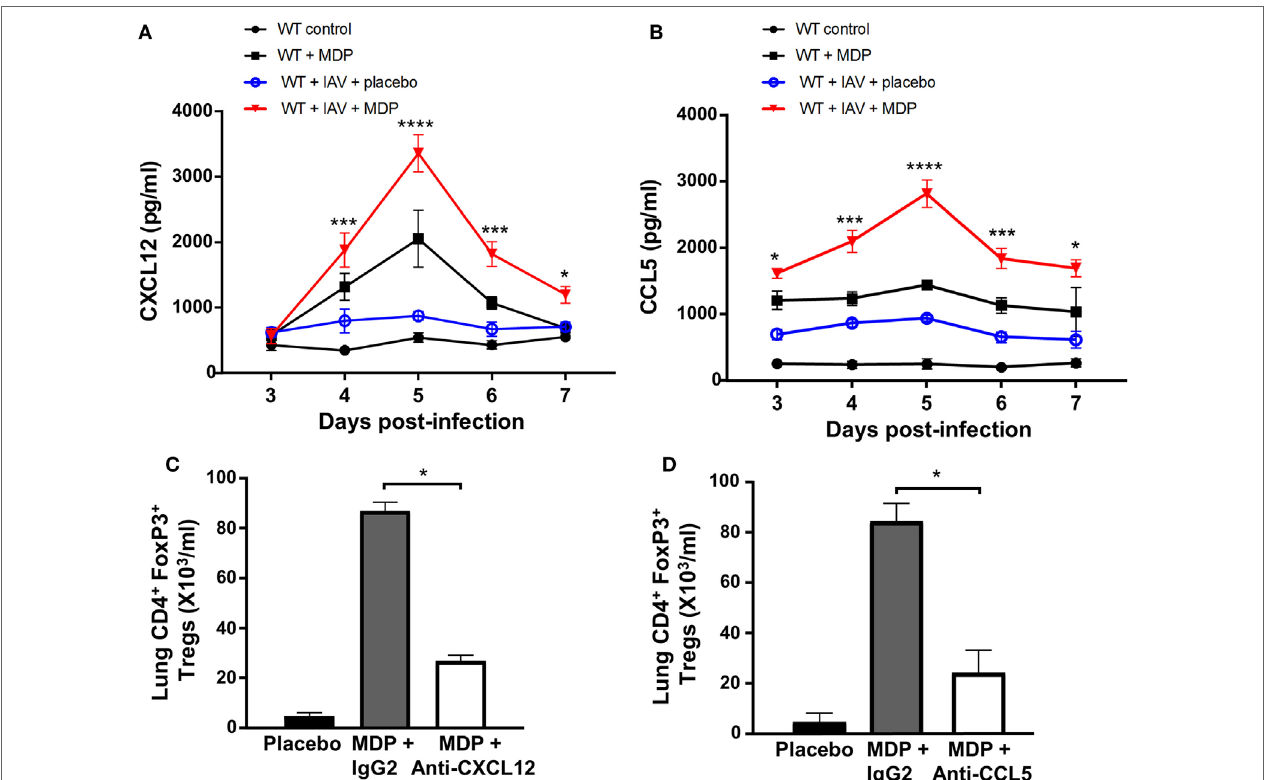
FigUre 3 | CXCL12 and CCL5 contribute to regulatory T (Treg) cell trafficking following muramyl dipeptide (MDP) treatment. Levels of (a) CXCL12 and (B) CCL5 production were measured in lung homogenates of influenza A virus (IAV)-infected wild-type (WT) mice daily treated with placebo or MDP. Lungs were collected at days 3, 4, 5, 6, and 7 postinfection. Results are presented as mean ± SEM of two independent experiments ( n = 4 mice/groups). Differences in groups were determined with a two-way analysis of variance followed by a Tukey post hoc test. * p < 0.05, *** p < 0.001, and **** p < 0.0001 as compared to IAV-infected mice treated with placebo. (c,D) Number of Treg cells to the lungs was analyzed by flow cytometry in IAV-infected mice injected with (c) anti-CXCL12 or (D) anti-CCL5 neutralizing antibodies and daily treated with MDP or placebo. Neutralizing antibodies or IgG2 isotype control (32 μ g/mice i.p.) was administered one day prior to IAV infection. Lungs were collected at day 5 postinfection. Results are presented as mean ± SEM of two independent experiments ( n = 3 mice/groups). Differences in groups were determined with a Mann–Whitney test * p < 0.05 when compared with indicated